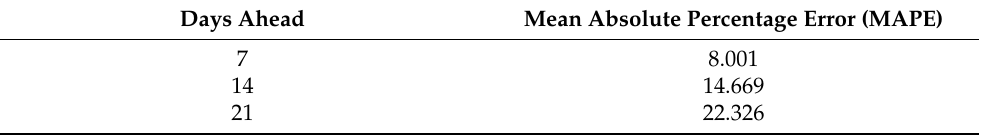
Table 1. Table of predictive results of the constellation network (Figure 9) predicting strawberry